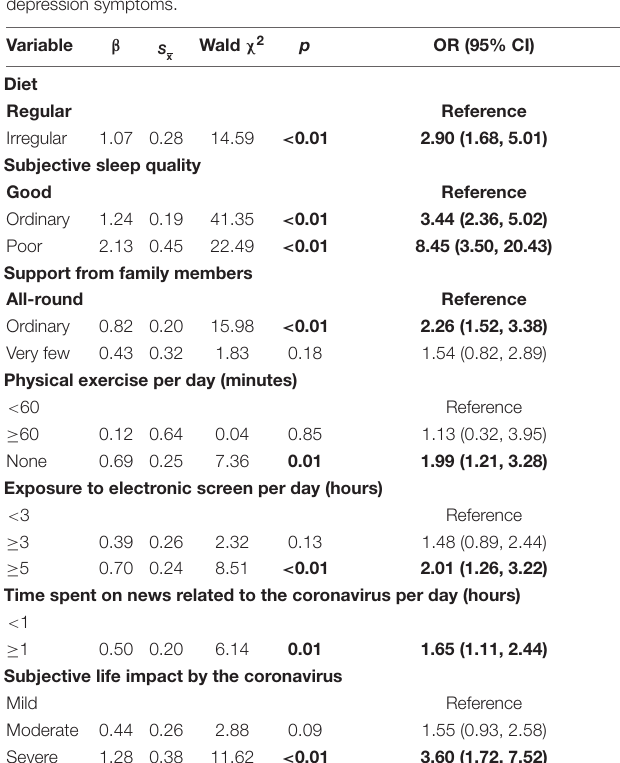
TABLE 3 | Multivariate logistic regression analysis of potential risk factors for depression